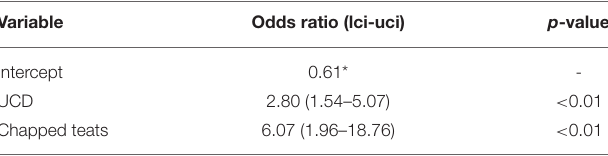
Indicates strong ITN associations with udder cleft dermatitis (UCD) and chapped teats (n = 217 farms). Wald’s method was used to calculate the lower confidence interval (lci) and the upper confidence interval (uci) and is indicated in parentheses next to the value for the odds ratio. UCD, udder cleft dermatitis on the farm. * Indicates the reference group used for each variable.